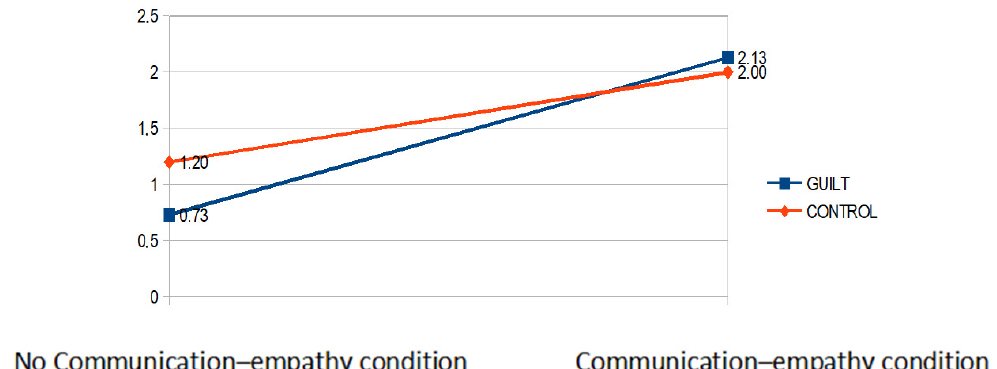
Figure 2. Mean of the tickets allocated to third person in each experimental